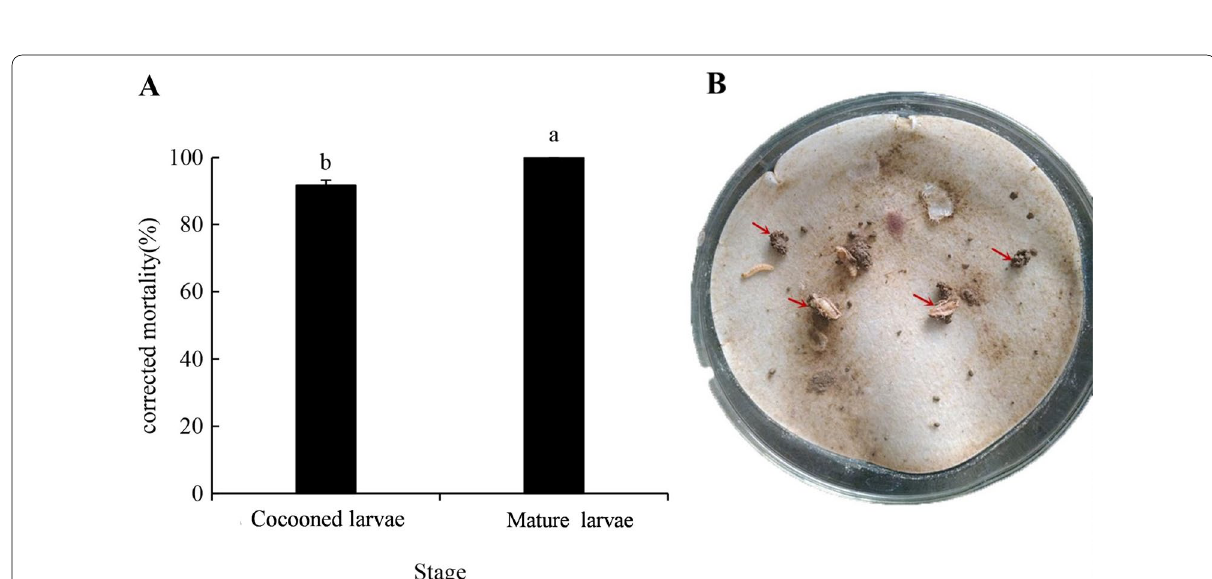
Fig. 3 Efficacy of Sgib nematodes on the cocoons and mature larvae of Atrijuglans hetaohei . A Corrected mortality of cocooned and mature larvae of A. hetaohei ; B The cocooned and mature larvae of A. hetaohei. The arrow indicates the cocooned larvae. Differing letters indicate values significantly different from one another at the p < 0.05 level (Tukey’s HSD